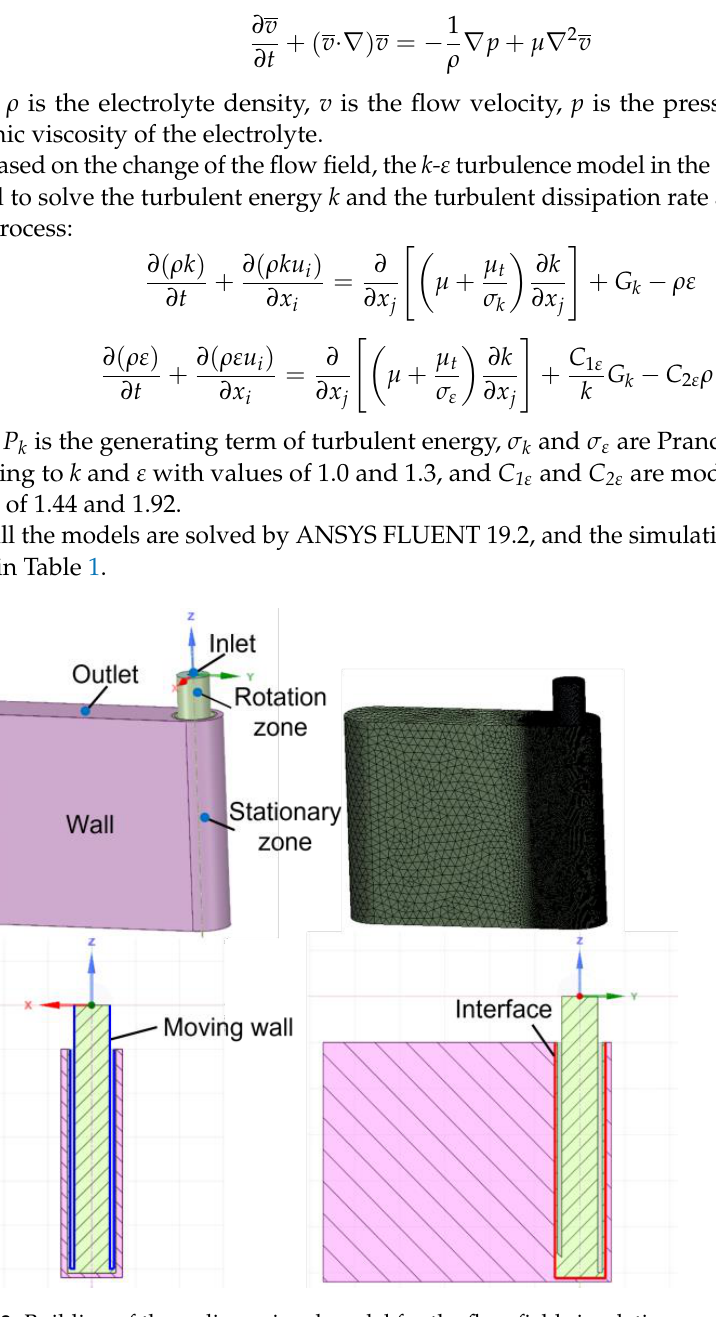
Figure 3. Building of three-dimensional model for the flow field simulation.